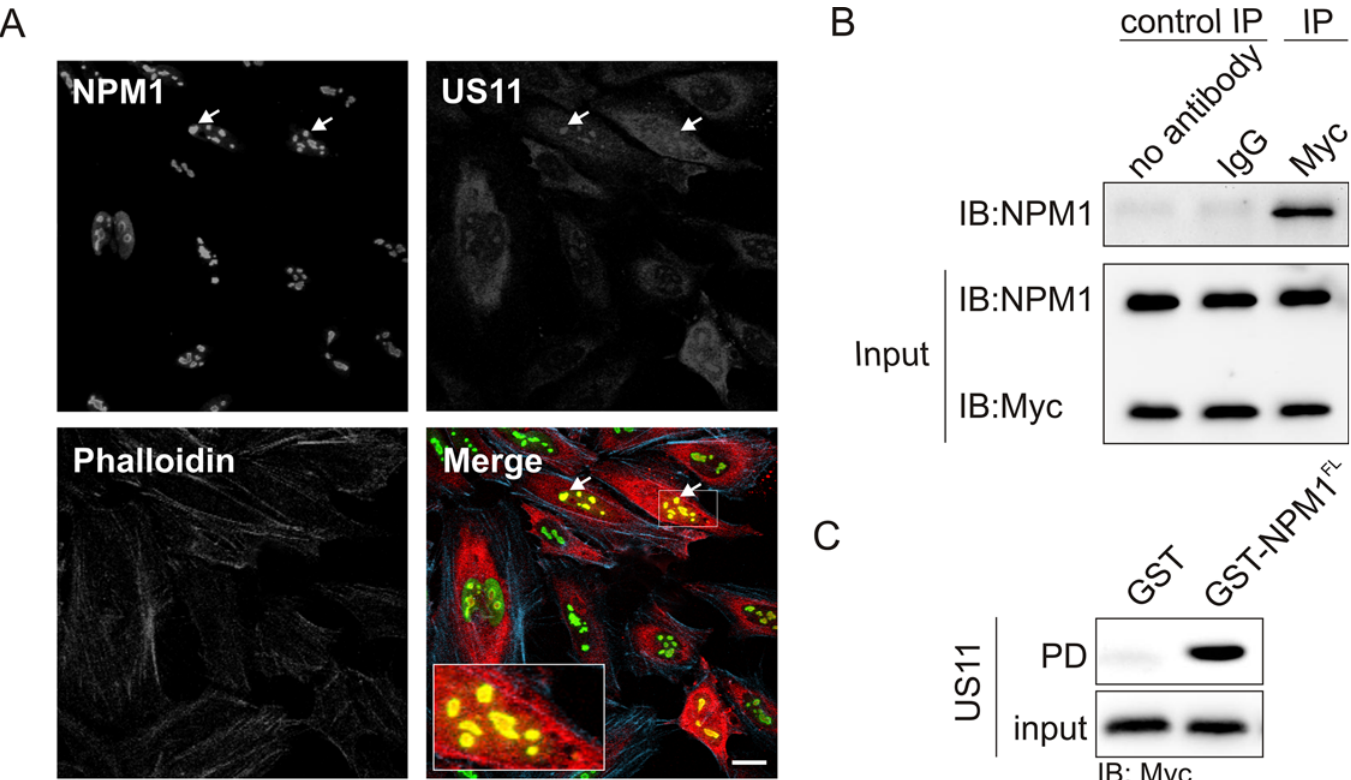
Fig 3. NPM1 association with HSV-1 US11 in the cell. (A) Nucleolar colocalization of endogenous NPM1 with myc-US11. Confocal images of HeLa cells transfected with myc-US11 were obtained by staining endogenous NPM1 (Mouse anti-NPM1 (ab10530)), myc-US11 (anti-myc antibody), and filamentous actin (rhodamine-phalloidin). For clarity, a boxed area in the merged panel shows colocalization of NPM1 and US11 in the nucleolus as pointed by arrows. Scale bar: 20 μ m. (B) Myc-US11 associates with endogenous NPM1 in COS-7 cells. NPM1 was co-immunoprecipitated with myc-US11 overexpressed in COS-7 cells using anti-myc antibody. A normal Rabbit IgG and sample without antibody were used as IP controls. Input, 5% of total cell lysate; IP, immunoprecipitation; IB, immunoblotting. (C) Myc-US11 FL displayed an interaction with NPM1 FL . Myc-US11 FL was pulled down with the GST-fusion NPM1 FL , but not with GST, which was used as a negative control. Samples prior pull-down (PD) analysis were used as input